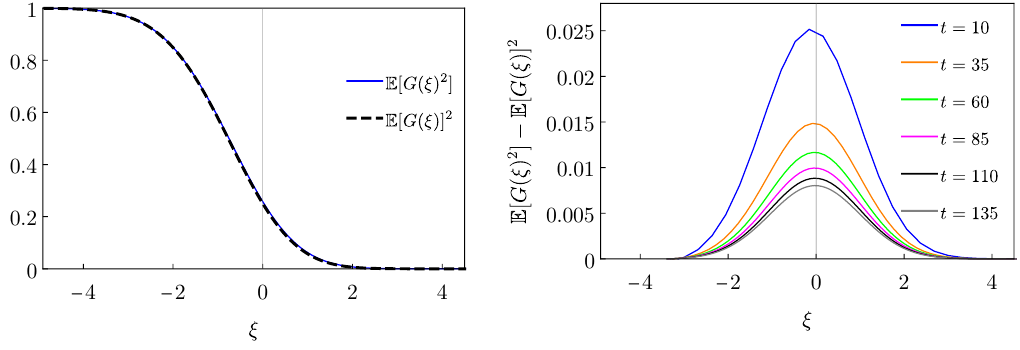
Figure 9: On the left we plot the comparison of (cid:69) [ G ( ξ ) 2 ] at time t = 150 (the blue line), and the square of expression (173) (the black dashed line). On the right we plot the difference between the asymptotic profile, and finite time results. The system size is fixed to L =